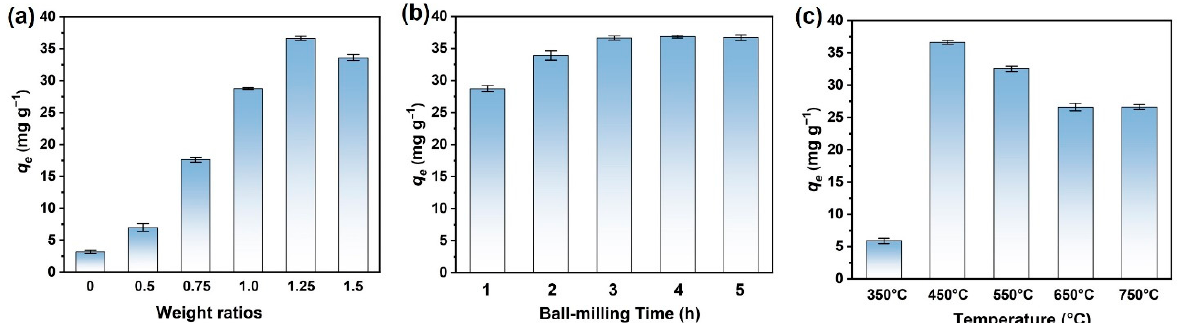
Figure 2. The adsorption capacities of MgBCs with different ( a ) mass ratios of MgCl 2 ·6H 2 O and biochar, ( b ) ball-milling time, and ( c ) pyrolysis temperatures.